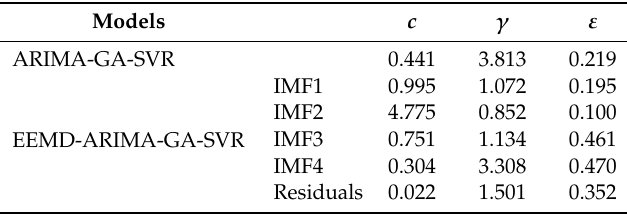
Table 2. The parameter selection of forecasting model optimized by